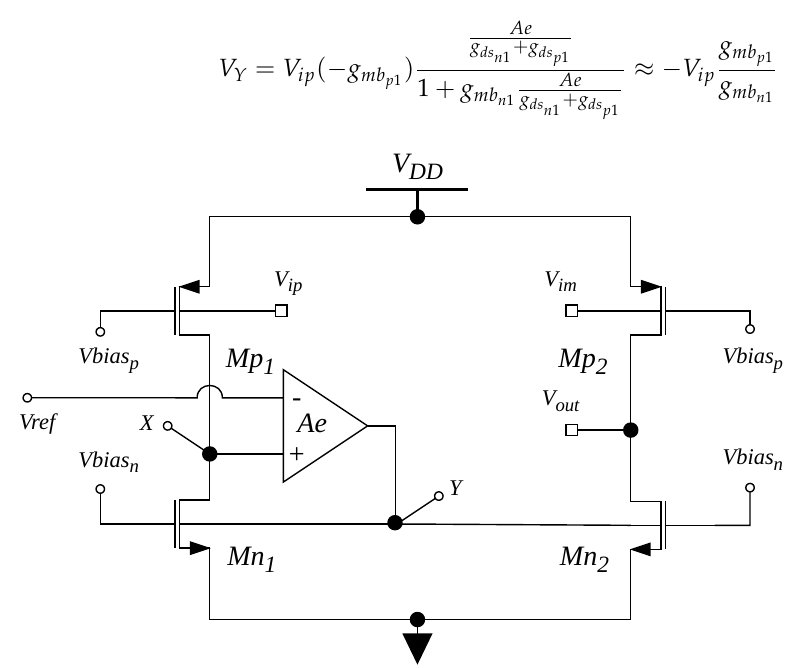
Figure 4. Conventional D2S converter: an enhanced BD-CM is employed.